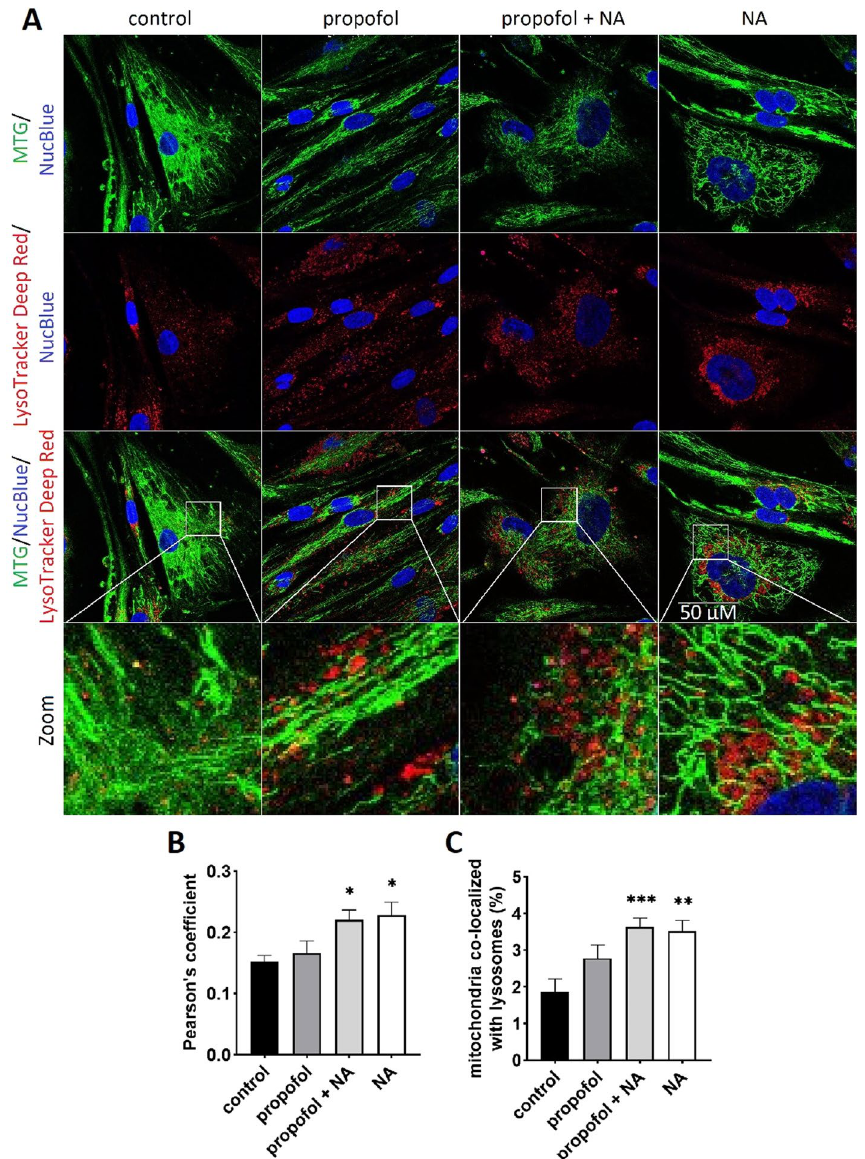
Fig. 4 Co-localization of mitochondria with lysosomes. A Representative confocal images of each channel after dual staining with Mitotracker Green ™ FM (accumulating in mitochondria) and LysoTracker ™ Deep Red (binding to acidic lysosomes). Additionally, all cells were stained with blue-fluorescent probe NucBlue to label nuclei. Experiments were performed at least at 40 cells per each condition from 3 independent measurements ( 3 individual subjects). B Pearson’s coefficient, characterizing a degree of overlap between = labelled mitochondria and lysosomes. The quantification of the co-localization was performed using ImageJ ™ plugin “JACoP”. C Percent co-localization was calculated by total area of co-localized lysosomes (red channel) over total area of mitochondria (green channel). Error bars indicate standard error of the mean. * p < 0.05, ** p < 0.01, *** p < 0.001 vs. control group. NA